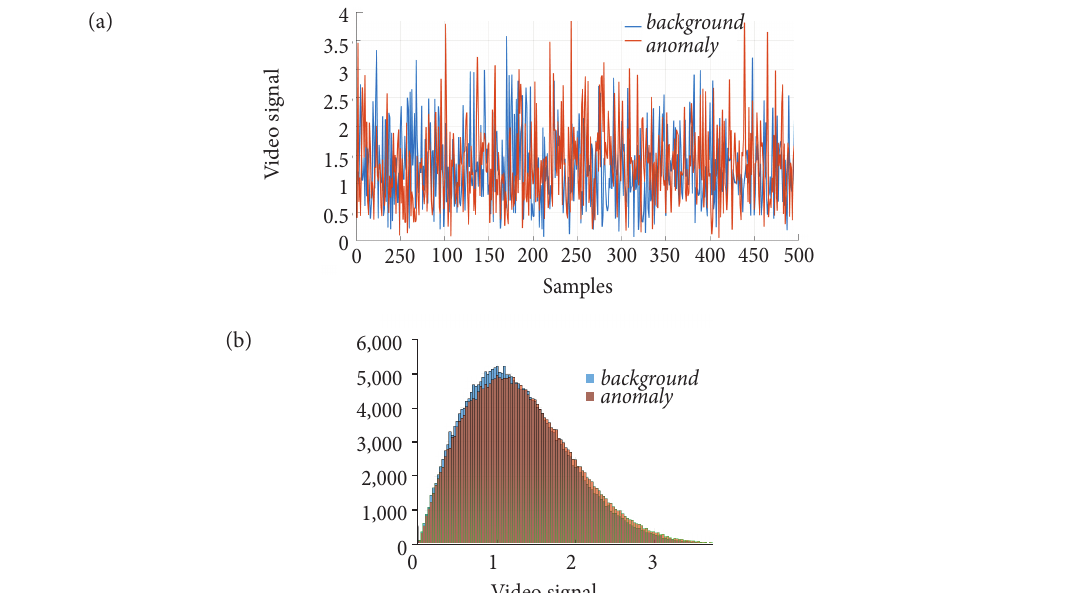
behavior under both hypotheses, taking and A = 0,4 in Eq. 24 and Eq. 25. In the left it is observed one of the 1000 realizations of the process corresponding to the cellular emission, while in the right are the histograms of all samples. From the two graphs, it is verified the high similarity of the video signal under both hypotheses, what hinders the correct decision making.